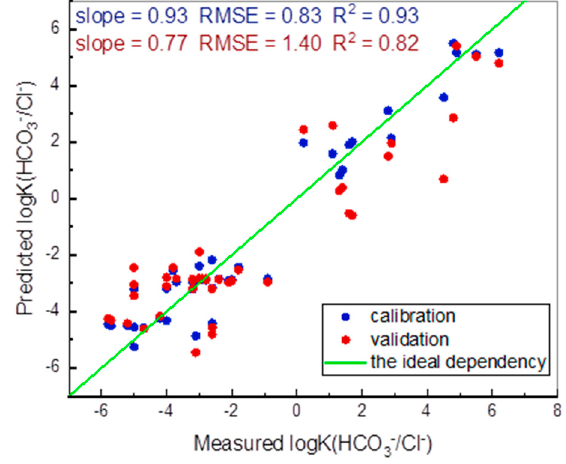
Figure 3. “Measured vs predicted” plot of cross-validated QSPR model for predicting the selectivity of membrane sensors. The green line corresponds to the ideal match between measured and predicted values.